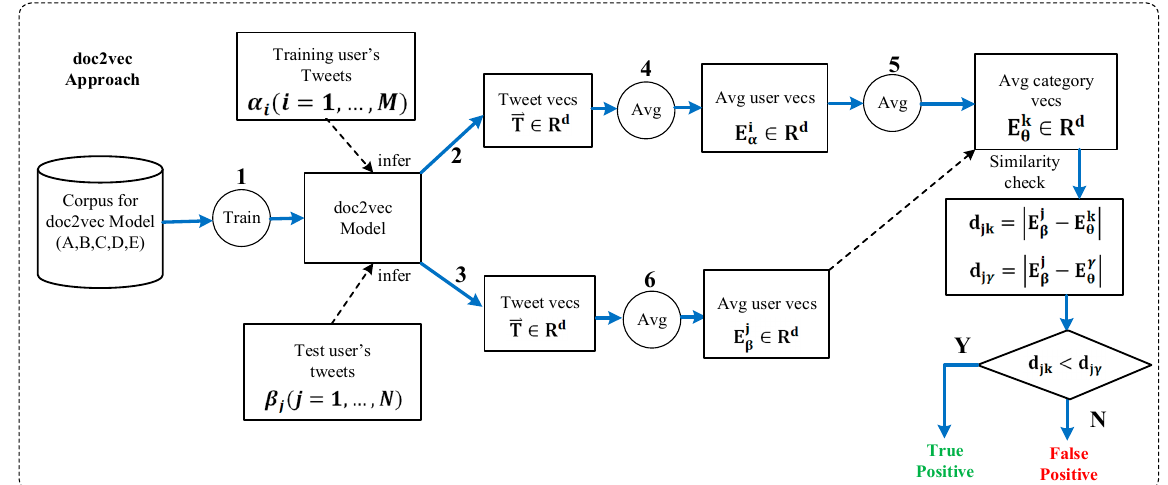
Figure 2. Overview of the doc2vec approach.